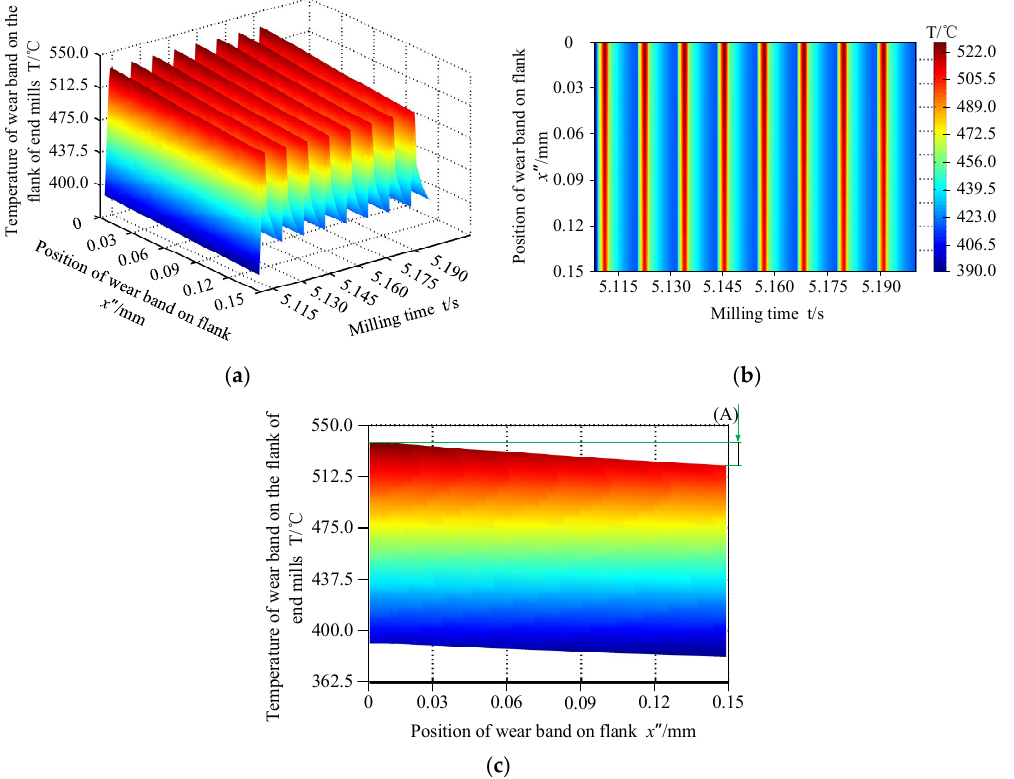
Figure 15. Transient temperature field simulation of wear band on the flank of end mills.